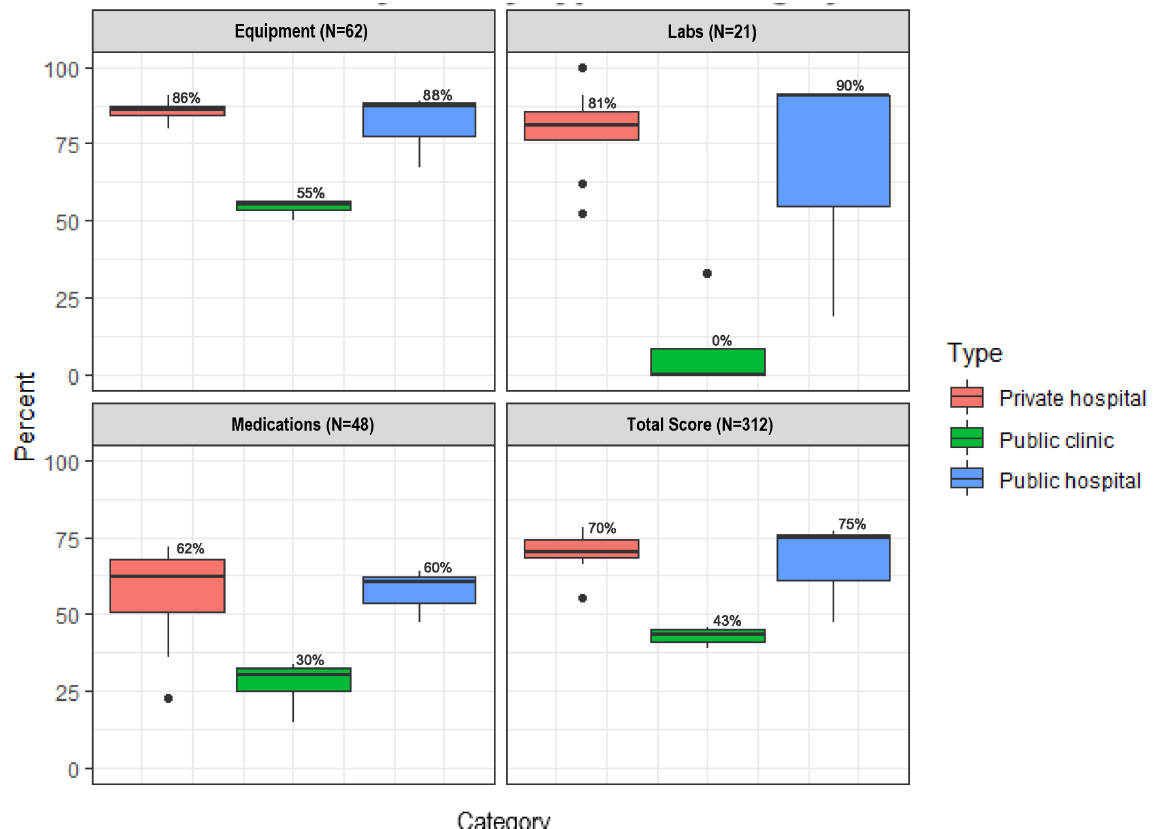
Figure 1. Performance by facility type and category. The displayed values are as follows: whiskers - 1.5* interquartile range; hinges - 25th and 75th percentile; middle -